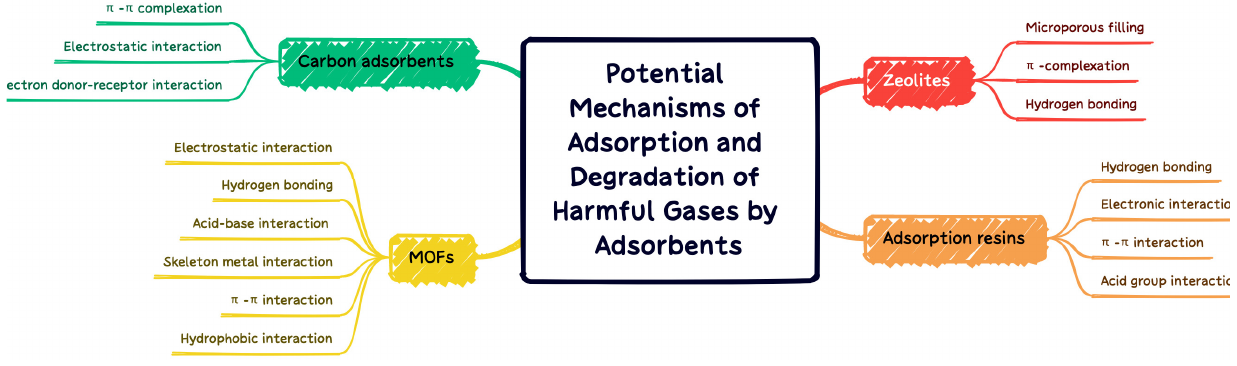
Figure 13. Adsorption and degradation mechanisms of carbon adsorbents, zeolites, adsorption res- ins, and MOFs. and